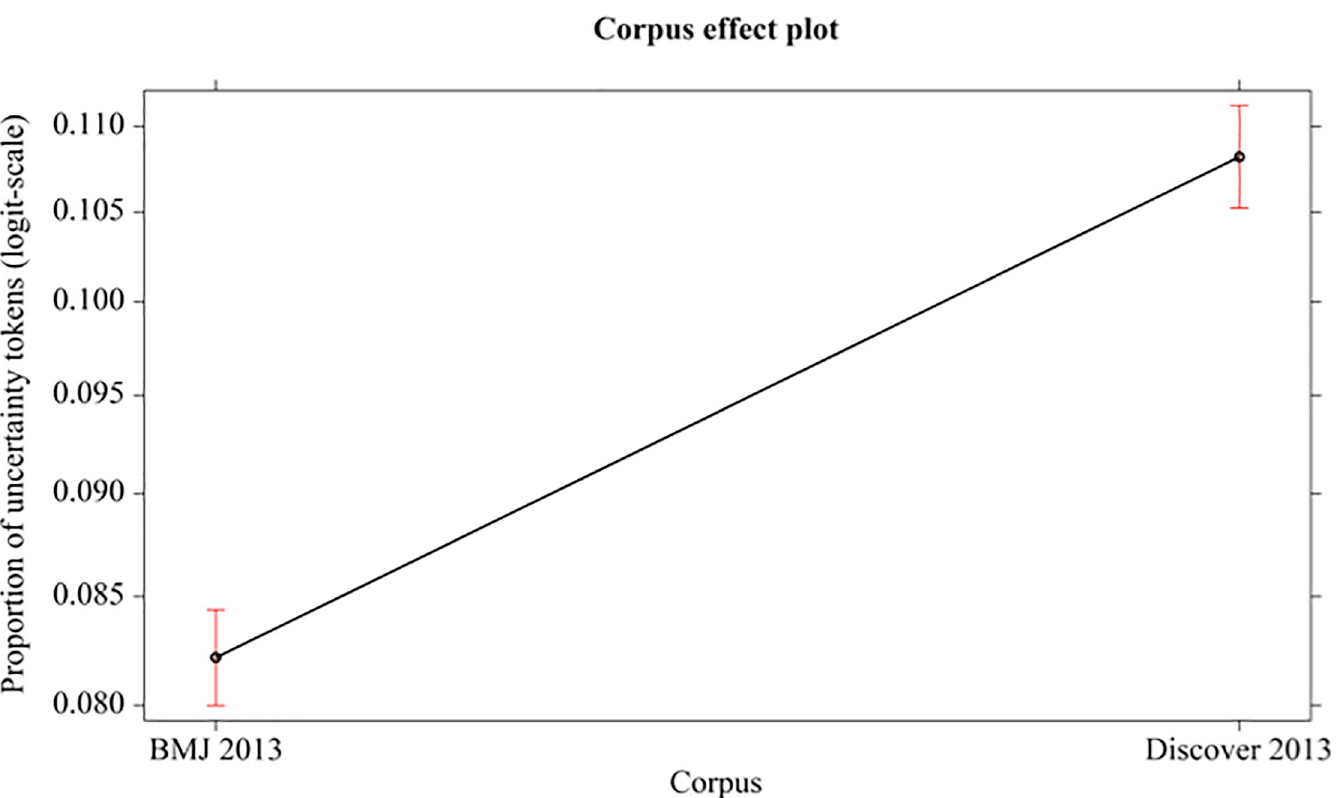
Fig 8. Mean proportions (95% confidence interval) of uncertainty tokens (in logit-scale) of different corpus (BMJ 2013, Discover